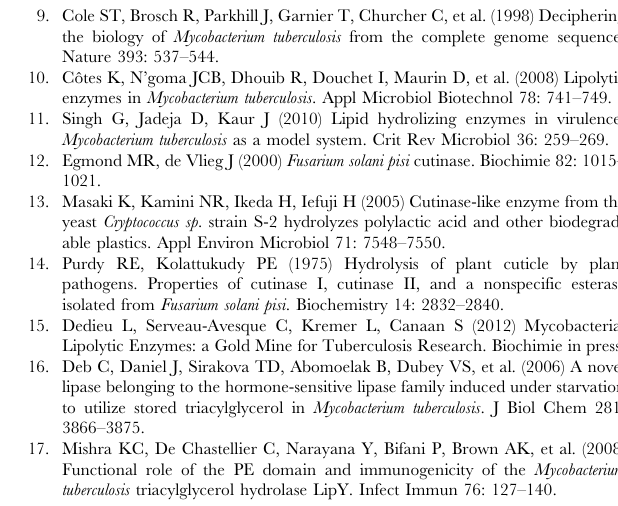
Table S1 Genes and physical properties of recombinant lipolytic enzymes. Table S2 Expression and purification conditions of M. tuberculosis Lip-HSL proteins. Table S3 Classification of genes encoding putative lipolytic enzymes found in the M. tuberculosis genome. Table S4 PMF analyses of HSL family members and modifica- tions after incubation with M m PPOX ( x I =